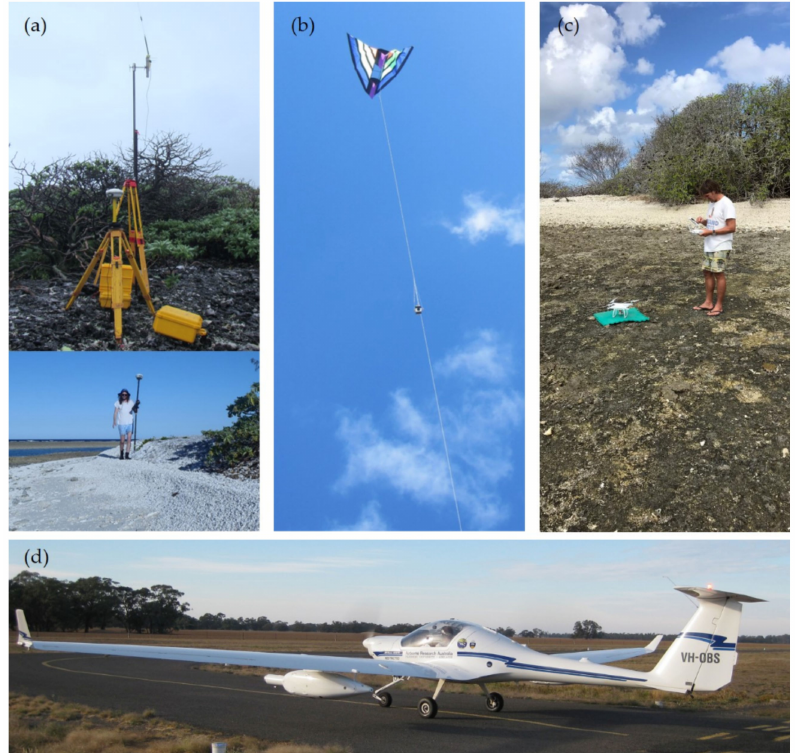
Figure 2. Examples of the ground-based and airborne methods used for this study: ( a ) Trimble RTK- DGPS R8, ( b ) Wingspan delta-coynes kite equipped with a 16 Mpx Sony NEX-5N, ( c ) DJI Phantom 4 Pro with an integrated 20 Mpx camera, and ( d ) ARA’s research motorglider carrying a Canon EOS 5Dmk4 DSLR and two Lidars in the underwing pods, a Riegl VQ-820-G topo-bathymetric scanner and a Riegl Q680-iS topographic scanner. Data from both scanners were combined to derive seamless above and below water topography across the OTI reef (Photo by Shakti